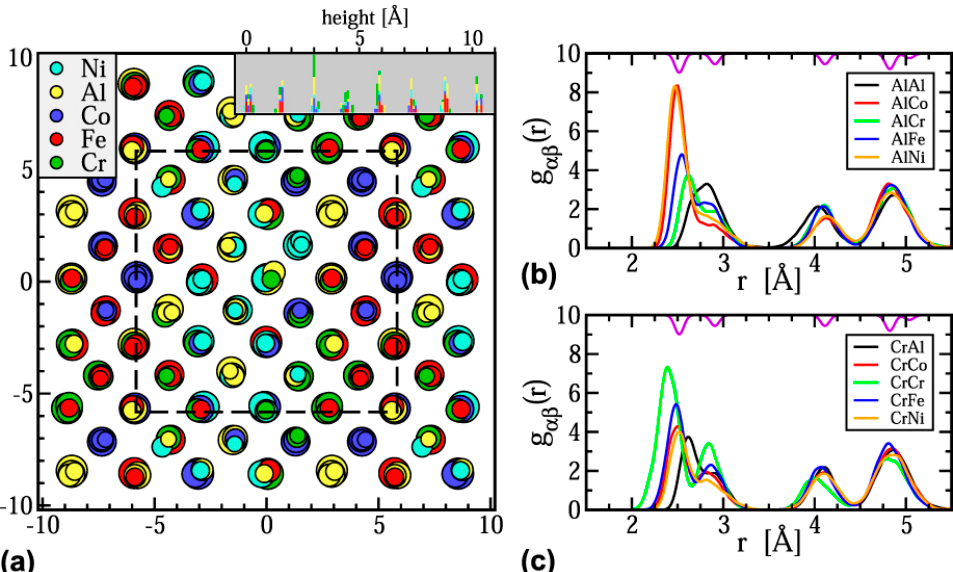
Figure 6. ( a ) Simulated structure of Al 1.33 CoCrFeNi at T = 300 K viewed along the [001] direction. ( b ) and ( c ) Partial radial distribution functions g αβ (r) showing the atomic distributions around Al and Cr atoms, respectively (this figure is from Reference